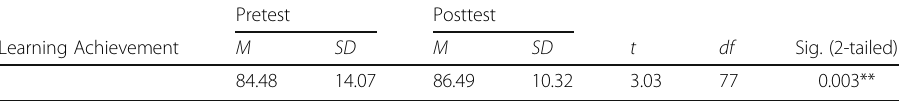
Table 3 Results of Paired t-test and Descriptive Statistics for Learning Achievement Pretest Posttest Learning Achievement